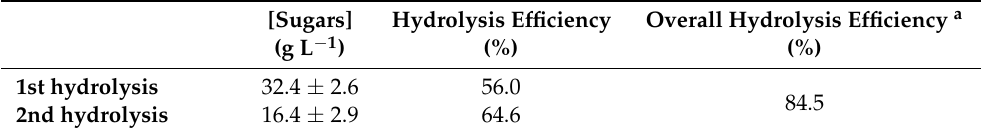
Table 2. Monosaccharide content and efficiency of BSG acid hydrolysis.